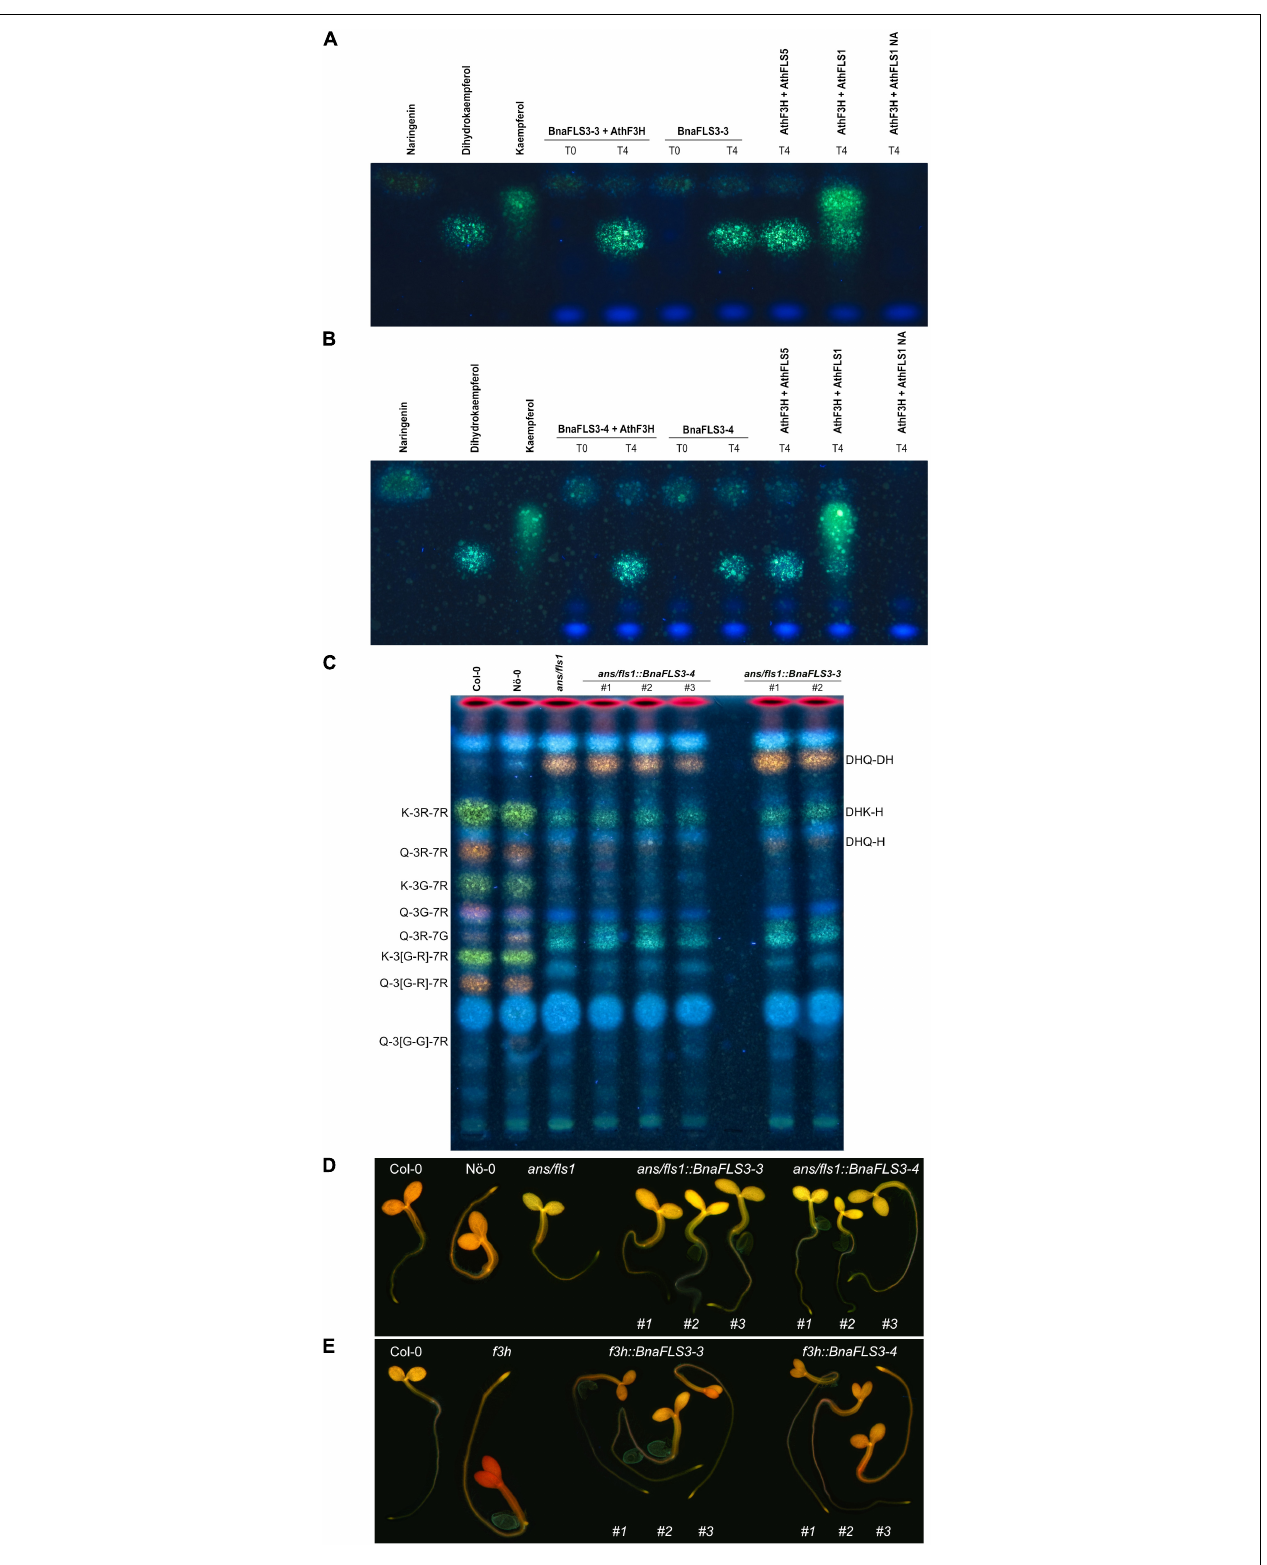
FIGURE 6 | BnaFLS3-3 and BnaFLS3-4 exhibit F3H activity. See Figure 5 for detailed figure description. (A) Bioconversion assay results of BnaFLS3-3 and (B) BnaFLS3-4. (C) The following flavonoid derivates were additionally labeled: dihydroquercetin-deoxyhexoside (DHQ-DH), dihydrokaempferol-hexoside (DHK-H), dihydroquercetin-hexoside (DHQ-H), quercetin-3-O-rhamnoside-7-O-glucoside (Q-3R-7G). (D,E) Flavonol staining in young seedlings.